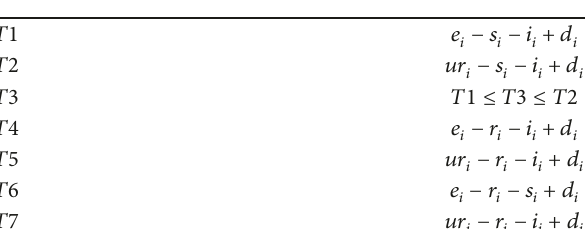
Table 1: Thresholds